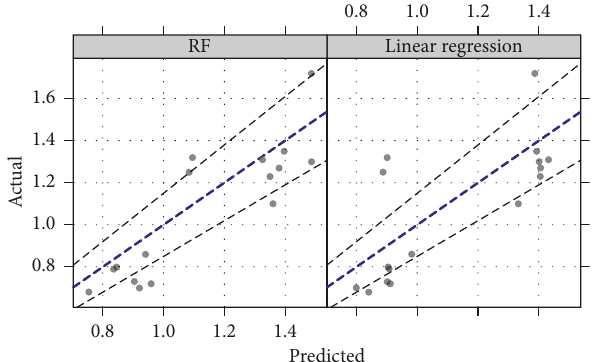
Figure 13: Error in EDZ prediction using random forests and linear regression methods for the test set.